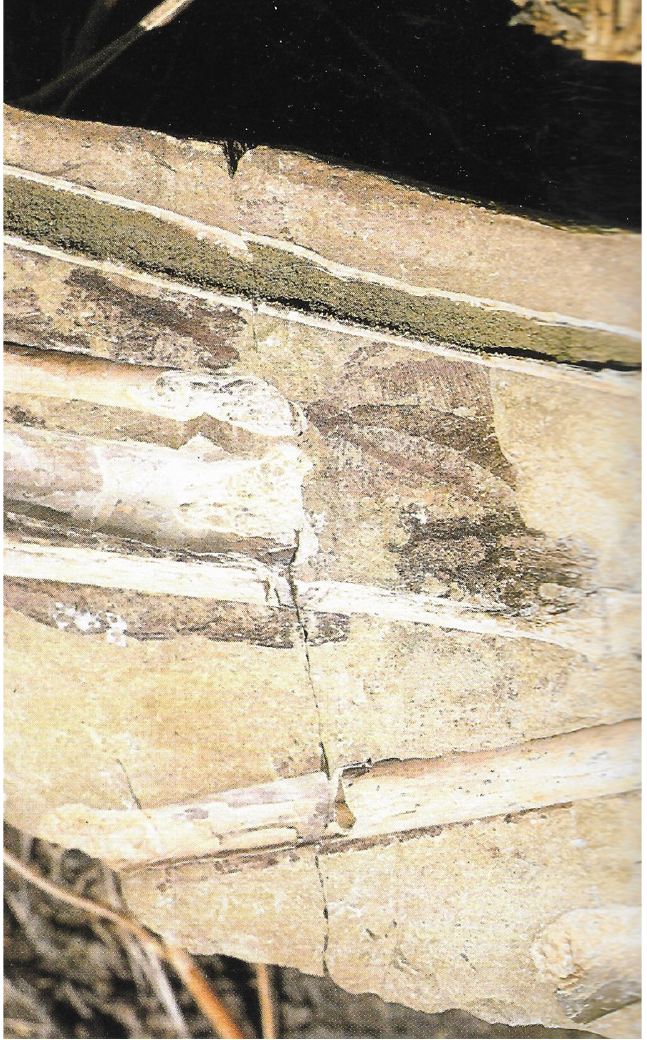
Figure 5. Part of the imprint of a pterosaur wing with striations of marks of collagen between the limb bones on a nodule. Araripe. North-East of Brazil. (photo